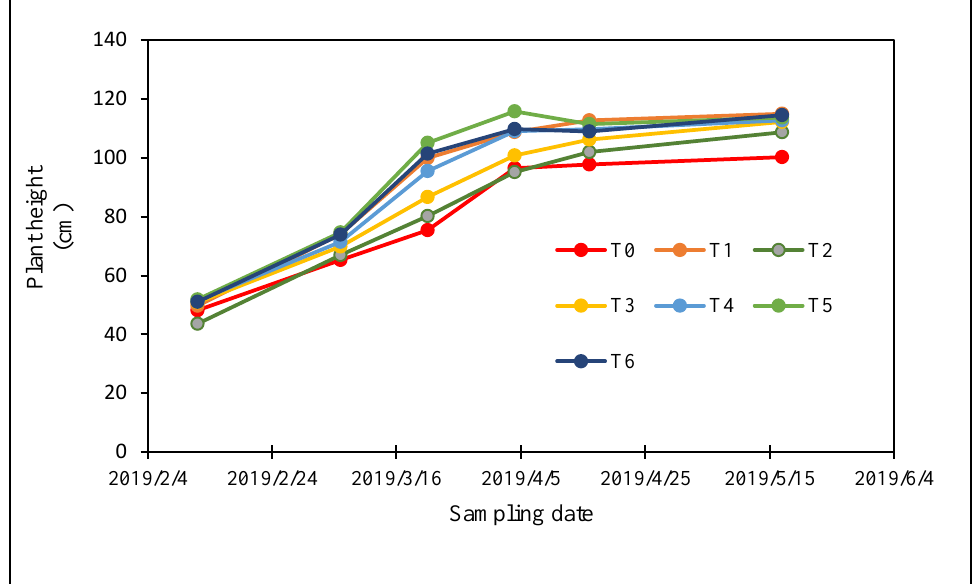
Figure 1. Effect of the different treatments on rice plant height; mean of 4 replicates; error bars were removed for clarity, T0: no fertilizer, T1: 100% urea, T2: 100% beef cattle manure, T3: 100% poultry litter, T4: 50% urea + 50% beef cattle manure, T5: 50% urea + 50% poultry litter and T6: 40% urea + 30% beef cattle manure + 30% poultry